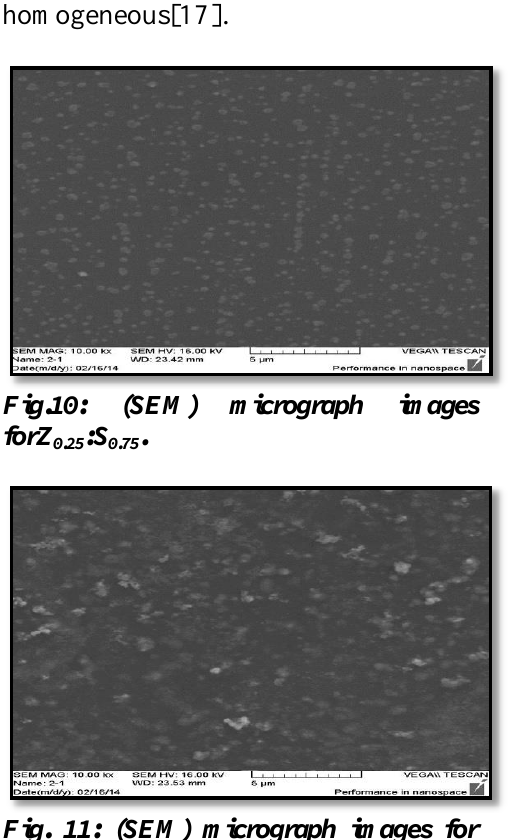
Fig. 11: (SEM) micrograph images for Z :S 0 1